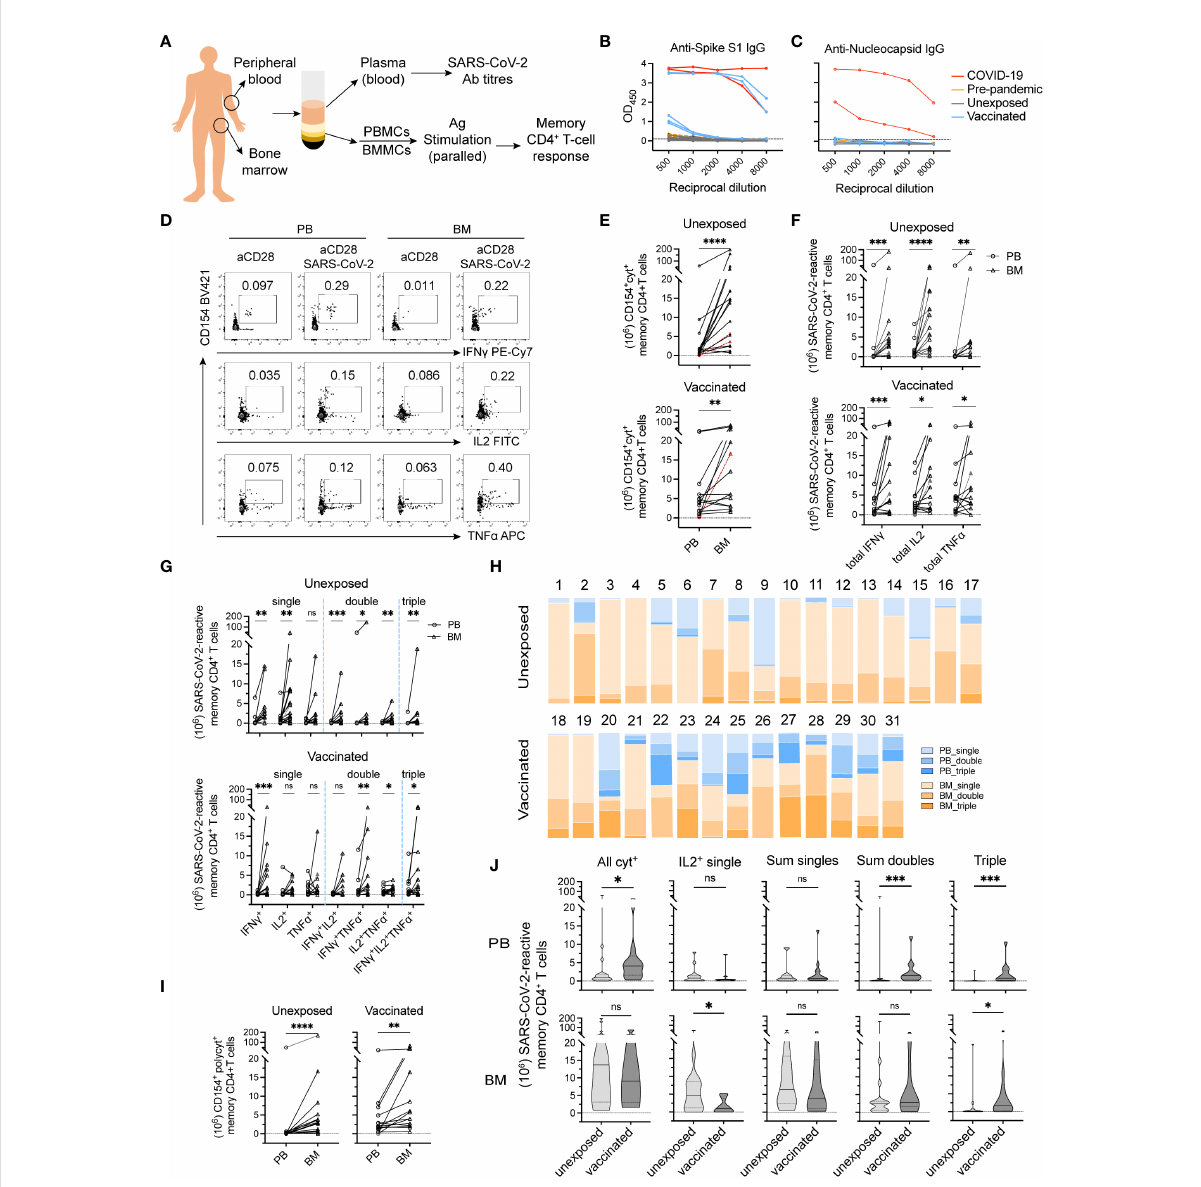
FIGURE 1 Bone marrow hosts polyfunctional memory CD4 + T cells against SARS-CoV-2 in both unexposed and vaccinated adult donors. (A) Flowchart of experimental setup. Mononuclear cells isolated from paired peripheral blood (PB) and bone marrow biopsy (BM) samples were collected from adult donors. Plasma from PB samples were collected for measuring IgG titers speci fi c for SARS-CoV-2 Spike and Nucleocapsid proteins. PBMCs and BMMCs were stimulated with S/M/N peptides mix of SARS-CoV-2 and analyzed for antigen-reactive memory CD4 + T cell responses. ( B + C ) Levels of antibodies to SARS-CoV-2 S (B) and N (C) proteins were measured using serial dilutions (two technical replicates of each dilution) of donor ’ s plasma in an Enzyme-Linked Immunosorbent Assay (ELISA). Red line, positive controls (n = 2) from acute phase ICU COVID-19 patients analyzed in previous study (1); yellow lines, negative control samples collected prior to COVID-19 pandemic (Pre-pandemic; n = 2); black lines, samples from unexposed donors (Unexposed; n = 17); blue lines, samples from COVID-19 vaccinated donors (Vaccinated; n = 5). The Y-axis corresponds to the mean optical density (OD) values assessed at 450 nm as depicted reciprocal dilutions on the X-axis. (D) Representative plots showing SARS-CoV-2-reactive memory CD4 + T cells expressing CD154 and one or more of the induced cytokine production (IL-2, TNF- a , or IFN- g ). (E – G) Estimated absolute numbers (29, 30) of CD154 + cytokine + ( E ; all cytokine producing cells), total individual CD154 + cytokine + (F) and single, double and triple cytokine-producing cells (G) . Symbols in red and dashed lines indicate estimated cell numbers of PB calculated according to frequencies under detection limit (10 -4 of memory CD4 + T cells). (H) Proportions of single, double, and triple cytokine-producing cells from (G) among total antigen-reactive cells (E) to the sum of PB and BM from donors analyzed on the individual levels. (I) Estimated absolute numbers of polyfunctional cells between paired blood and bone marrow samples. (J) Shown are estimated absolute numbers of indicated cell types in unexposed vs vaccinated donors. Values are presented as median (thick line) with 25 th - and 75 th -percentile. * p < 0.05, ** p < 0.01, *** p < 0.001, **** p < 0.0001; ns, not signi fi